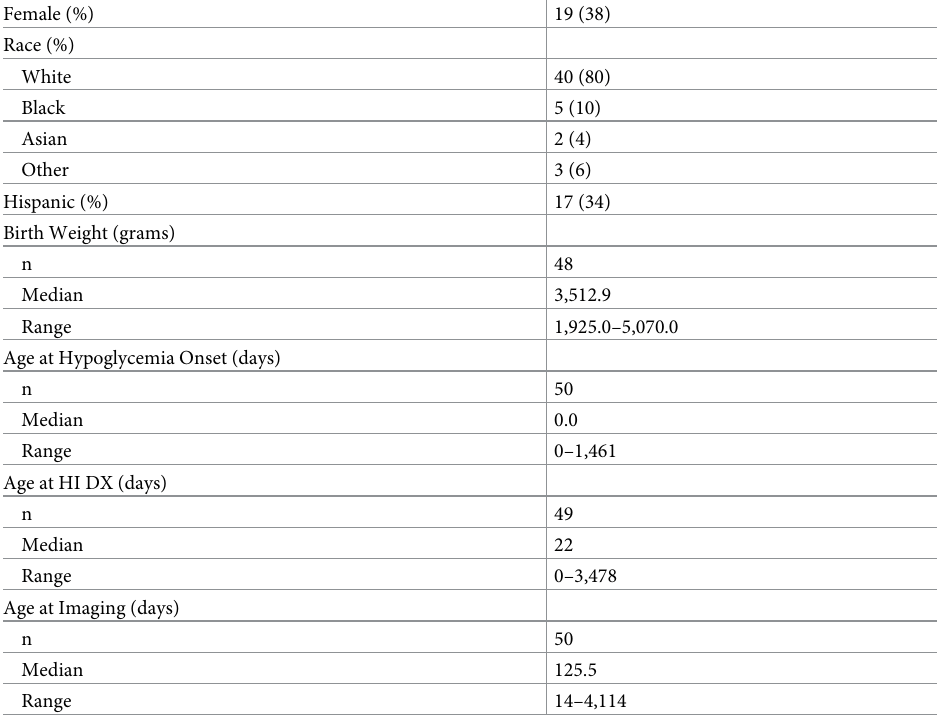
Table 1. Demographics of 50